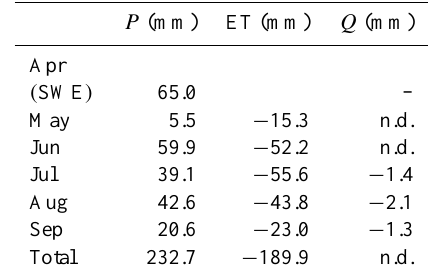
Table 8. Water balance estimates for Samoylov Island in 2008. Pre- cipitation ( P ) includes snow water equivalent in April (from snow transects), and rainfall measured in a tipping bucket gauge as well as manually. Evapotranspiration (ET) was derived from eddy co- variance measurements (Langer et al., 2011). Runoff ( Q ) figures for the island are only available from